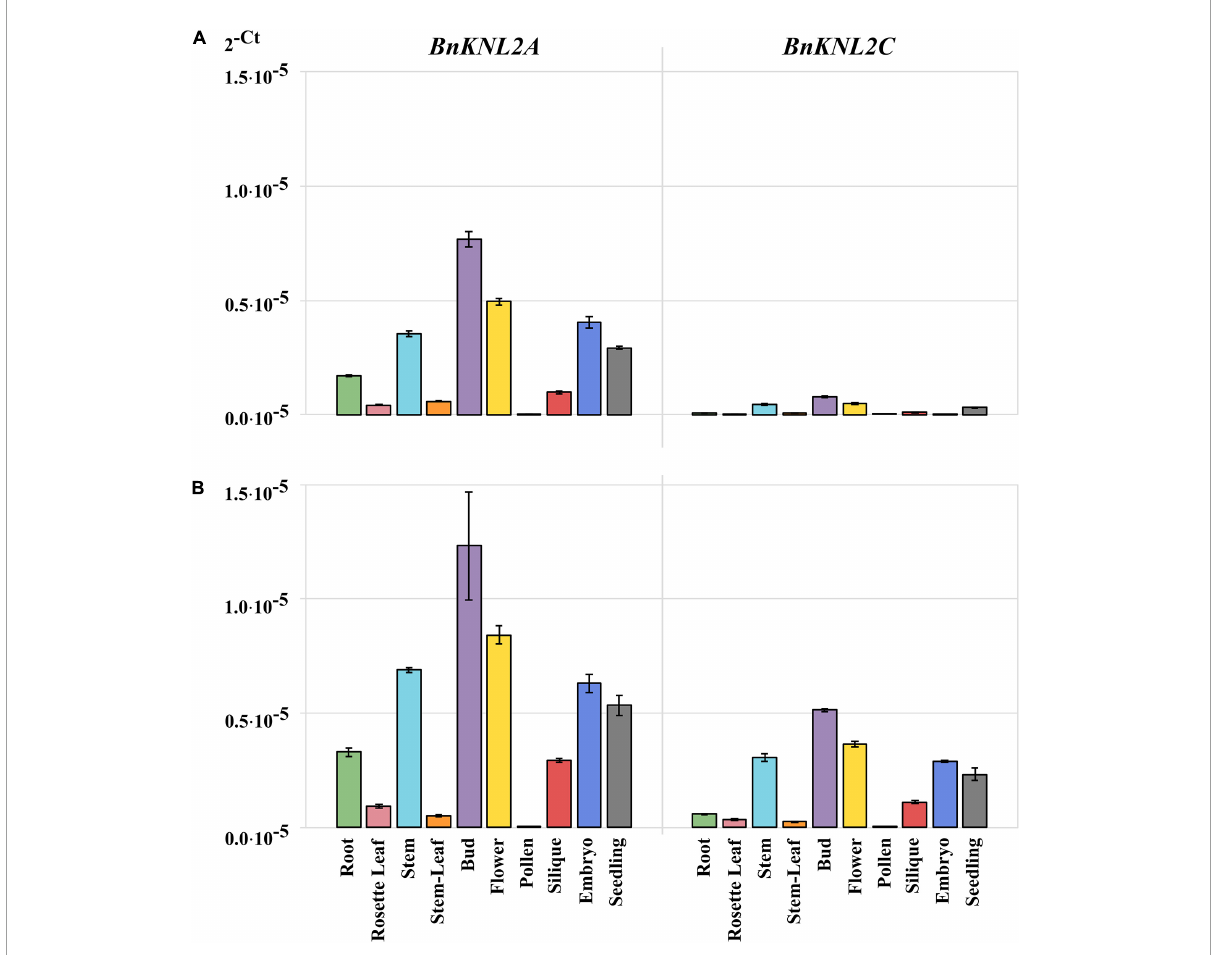
FIGURE4 Comparison of transformed cycle-threshold (2 - ct ) values of BnKNL2A and BnKNL2C transcripts in all analyzed tissues of B. napus ( v. Palma ). (A) cDNA, synthetized with unspecific oligo (dT) 18 and measured in a transparent qPCR plate. (B) Specific cDNA, synthetized with antisense oligonucleotides of the corresponding gene and measured in a white qPCR plate. Error bars: standard deviation of sample (N-1) N =